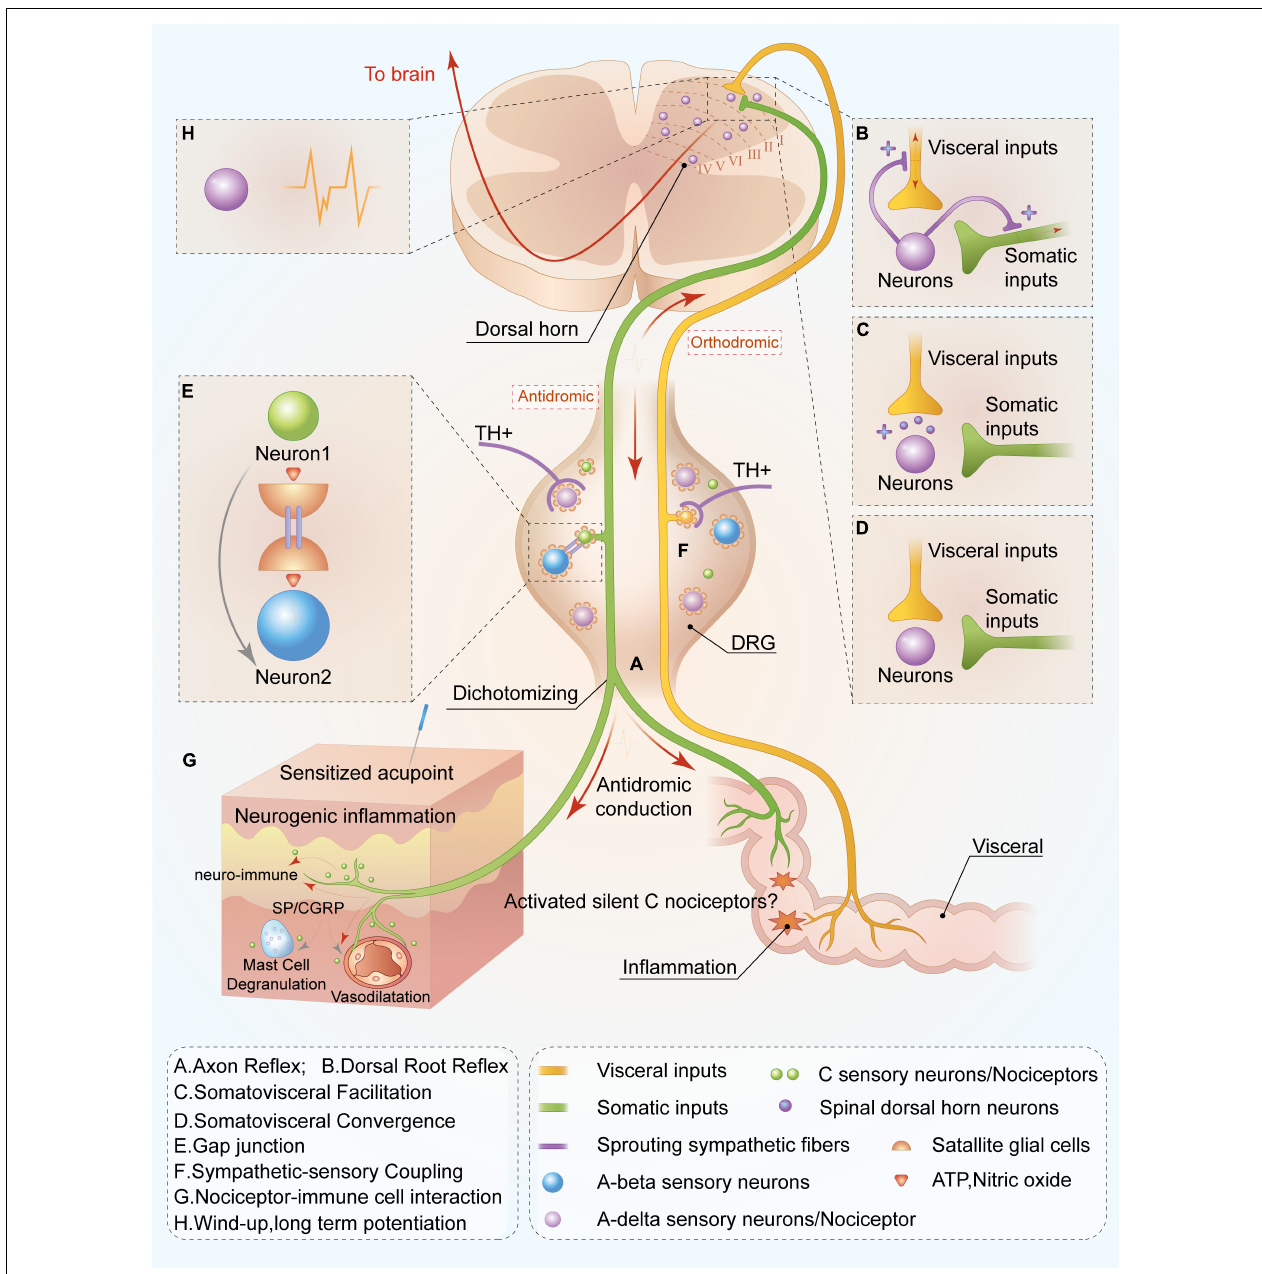
FIGURE 1 | Peripheral and spinal mechanisms of C-nociceptor in acupoint functional plasticity. C nociceptors innervated in the viscera are capable of sensing inflammatory or tissue injury. Noxious signals are orthodromic transmitted not only to spinal and supraspinal levels but also antidromic transmitted to the cutaneous area on the adjacent spinal segments through nociceptors mediating peripheral nerve reflex or the mechanism of somatovisceral convergence and facilitation, resulting in acupoint sensitization at the adjacent spinal segments. Ultimately, increasing levels of C nociceptors distributed in the sensitized acupoints are activated, mediating the functional plasticity of acupoints by enhancing the capacity to respond and deliver acupuncture signaling or peripheral stimulations. Through axon (A) and dorsal root reflexes (B) , visceral noxious signals are antidromically transmitted to the cutaneous area on the adjacent spinal segments, releasing substance P, and calcitonin gene-related peptide and resulting in neurogenic inflammation and neuro-immune reaction (G) . Meanwhile, the activated visceral dorsal root ganglia (DRG) neuron is capable of releasing bioactivators and resulting in sympathetic postganglionic fibers sprouting in DRG (F) and simultaneously activating visceral DRG neuron release adenosine triphosphate (ATP) and nitric oxide to sensitize neighboring neurons via gap junction (E) , leading to more sensory neuron activations. This is involved in the transmission and response of acupuncture treatment. Notably, C silent nociceptors can be “awakened” in the aforementioned inflammatory environment and participate in noxious sensory transmission. In the spinal dorsal horn, noxious inputs from the viscera also lead to excitation of somatic sensory central terminals via facilitation (C) and convergence (D) of somatic and visceral neurons. Moreover, peripheral noxious inputs induce the plasticity of spinal dorsal horn neurons (H) , increasing sensory inputs to supraspinal level and improving responsive capacity to peripheral acupuncture application. Overall, this mechanism contributes to the plasticity of acupoint function by improving the capacity to respond to acupuncture treatment.